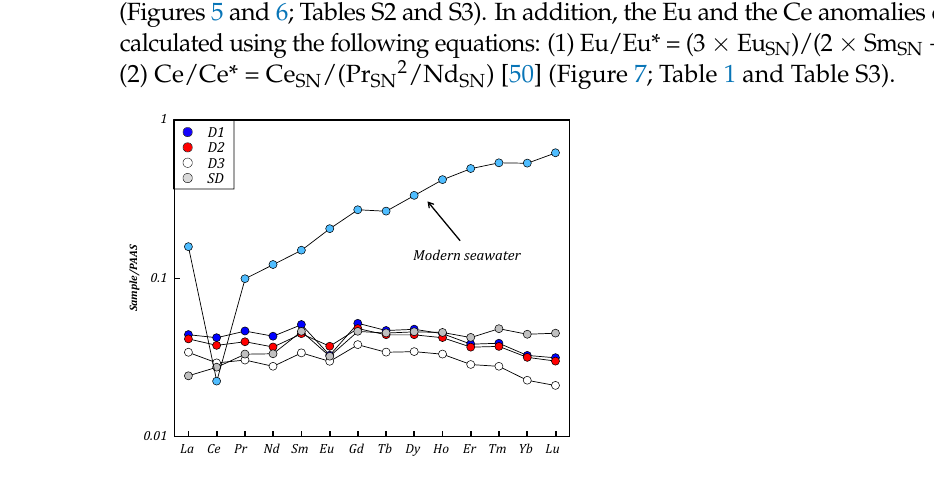
Figure 5. PAAS-normalized REEs partition patterns of different types of the examined dolomites in the Xixiangchi Formation and the modern seawater (data form [51]. Note the REE compositions of some of D1, D2, and SD samples have been previously reported by Liang et al. [45]. See Tables S2 and S3 for details.